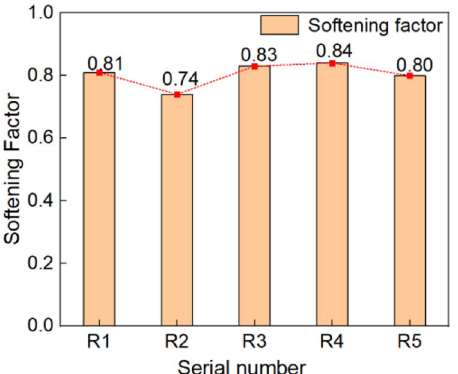
Figure 23. Histogram of softening coefficient of each